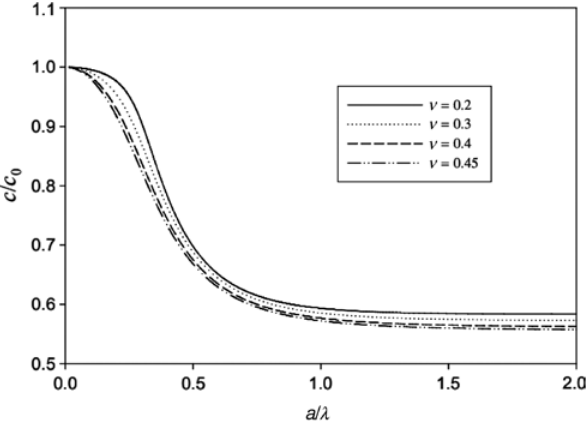
Figure 3: Dimensionless phase velocity of the longitudinal mode of a rod for various Poisson’s ratio values. Reprinted with permission from [42]. Copyright (2003)